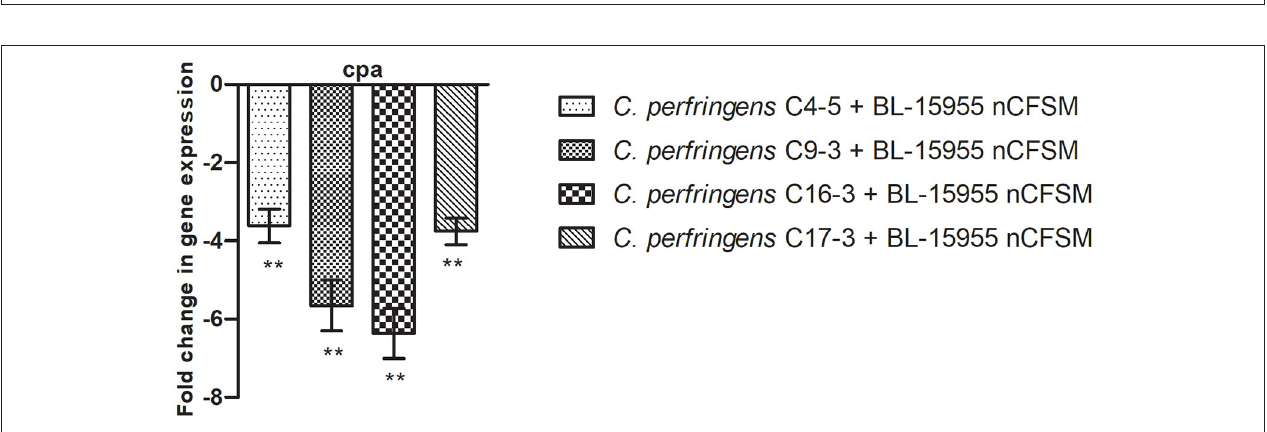
fold, flhD with 2.7 to 25.7 fold, prgL with 3.7 to 258 fold, ssaG with 2.0 to 82.8 fold, and fliC with 2.2 to 22.8 fold expression ( Figure 5